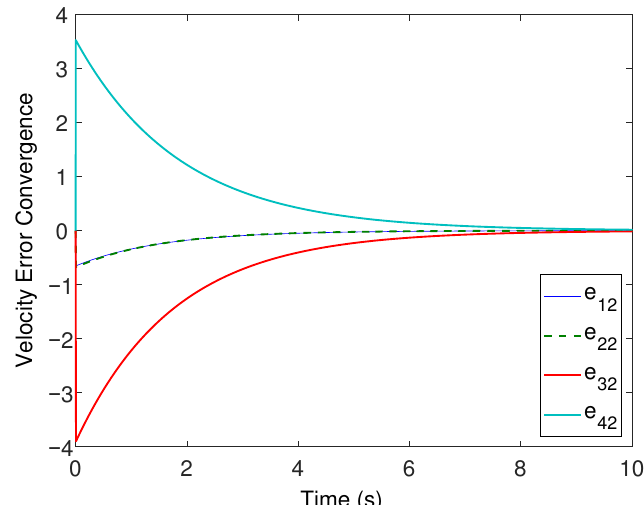
Figure 6. Velocity errors’ convergence.